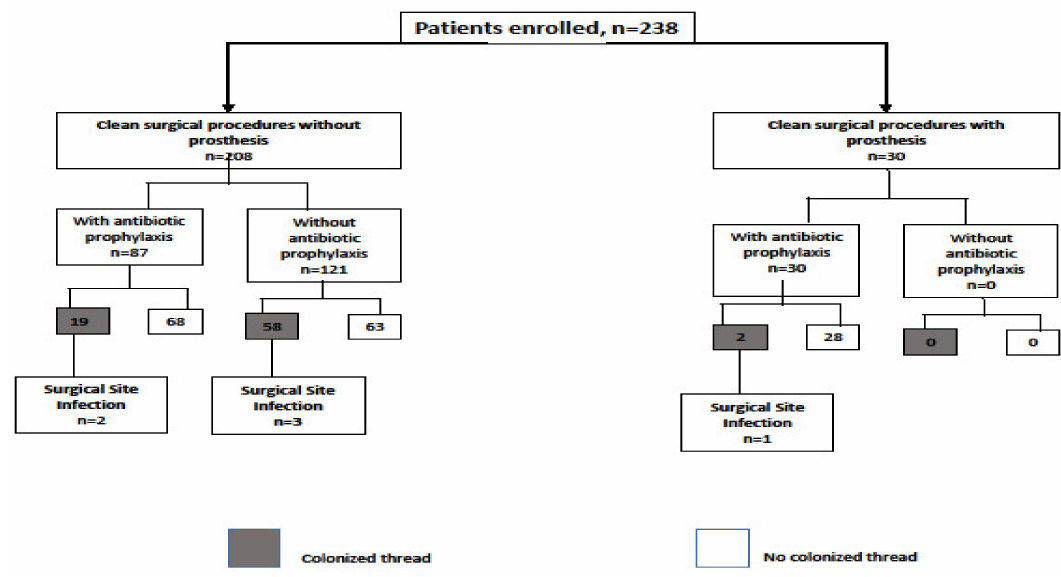
Figure 2. Flow chart of study participant